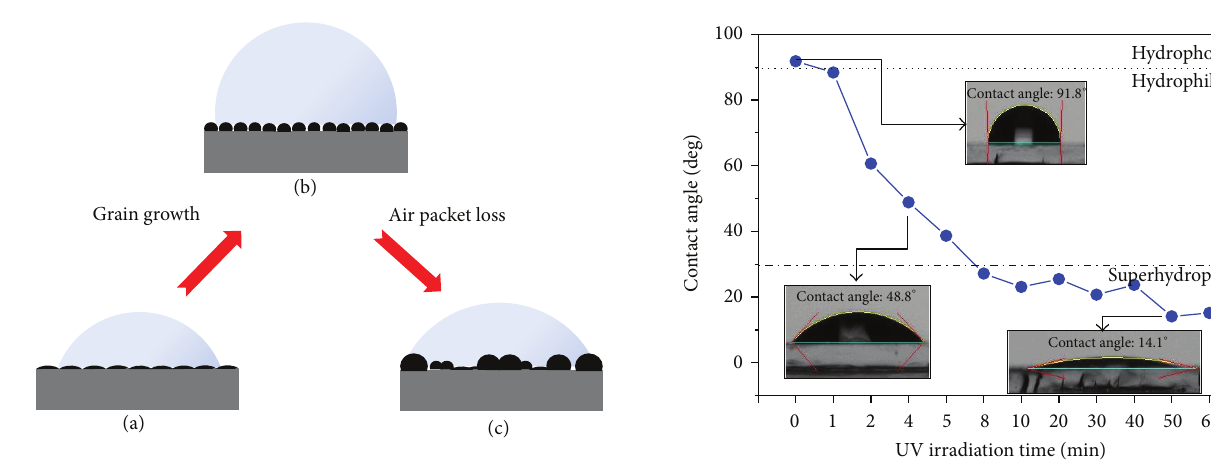
Figure 7: Time dependence of water contact angles (CAs) for the ZnO thin films deposited at 100 W under ultraviolet (UV) photoir- radiation with the light wavelength of 365 nm. Inset showed the corresponding water CA images accompanied with the measured values of the ZnO (0002) columnar